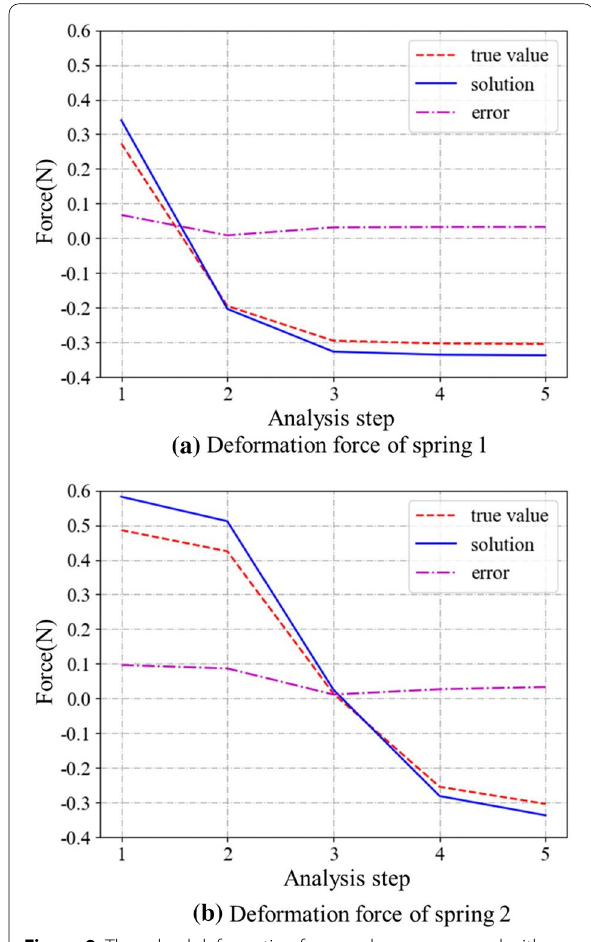
Figure 9 The solved deformation force and error compared with true value for the milling depth of 8 mm